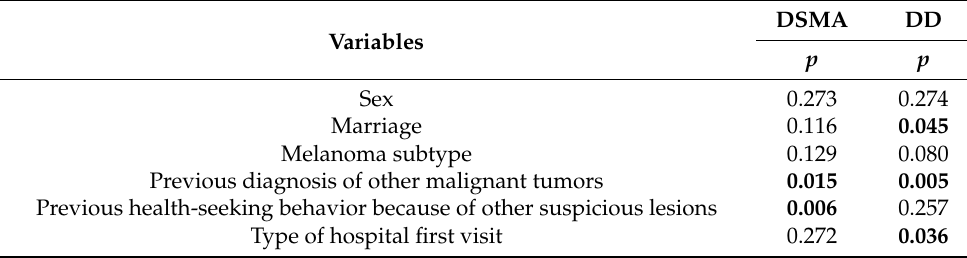
Table 3. Mann–Whitney U test between DSMA and DD and